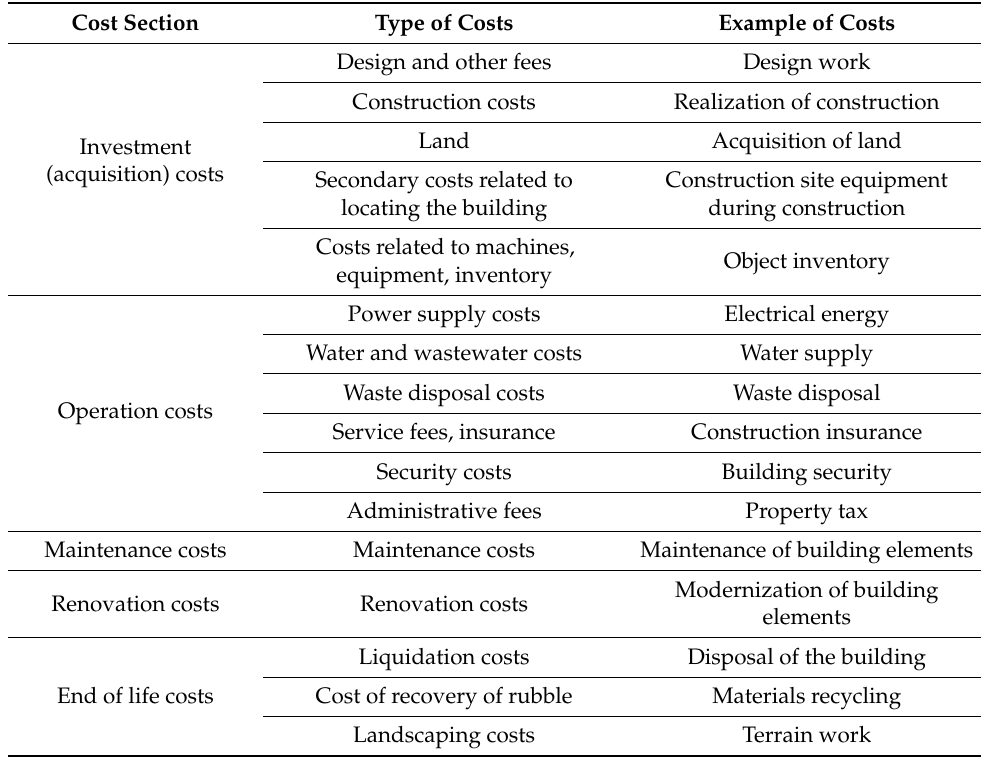
Table 1. Structure of life cycle